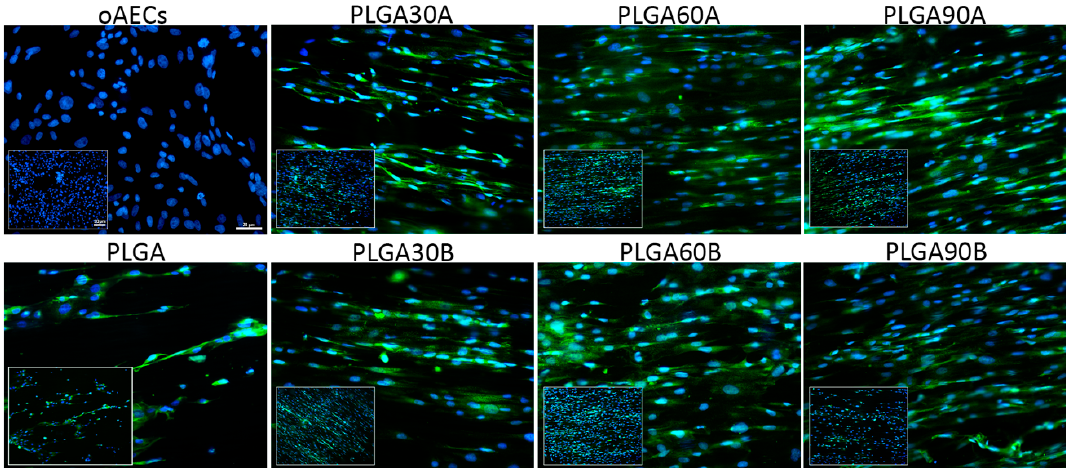
Figure 8. Teno-inductive properties of untreated and CAP treated PLGA microfibers on AECs. Immunocytochemical analysis revealed TNMD protein expression (green fluorescence) in oAECs seeded onto untreated and CAP treated PLGA microfibers after 24 h; whereas cells cultured on Petri dishes do not express this protein. DAPI (blue fluorescence) counterstained nuclei. Positivity to TNMD was evident in the cytoplasm of the oAECs. Scale bars = 20 µ m. Insets show the same images at a lower magnification; scale bars = 50 µ m; ( n = 3 for each type of sample / time point, sample size: 15 mm × 7 mm).